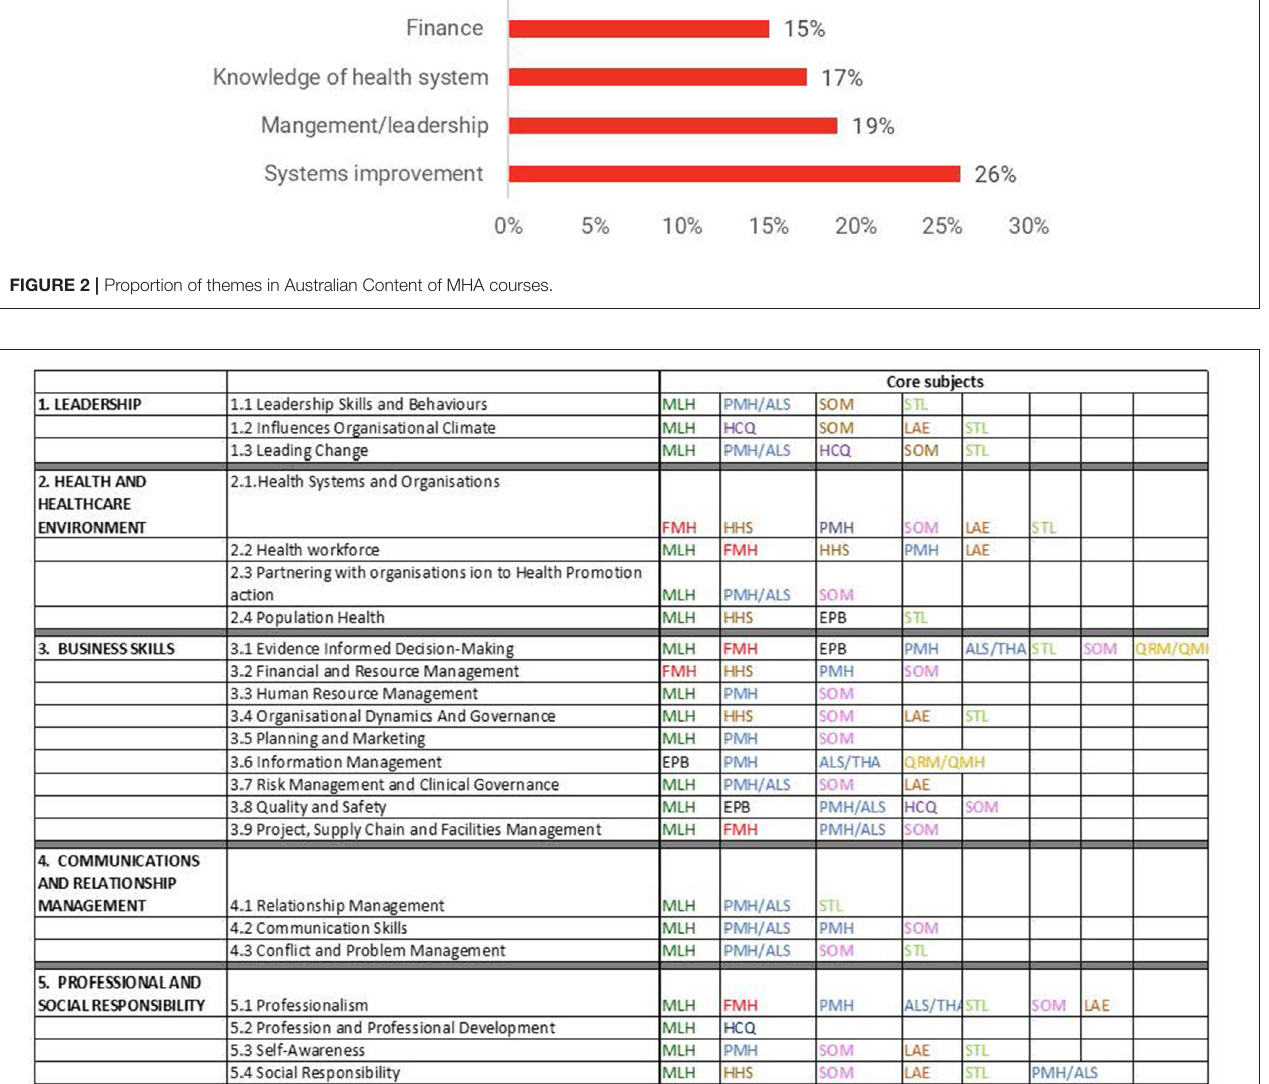
FIGURE 3 | Mapping of subjects against core competencies of the accrediting organisation PHE5HHS -Health Systems; PHE5SOM – Strategy and operation management; PHE5FMH – Financial Management in Health Services; PHE5MLH- Management and leadership in Health; PHE5HCQ -Health Care Quality; PHE5EPB - Epidemiology and Biostatistics; PHE5LAE- Health law and Ethics; and PHE5STL- System thinking and Leadership; ALS-Action learning studies).